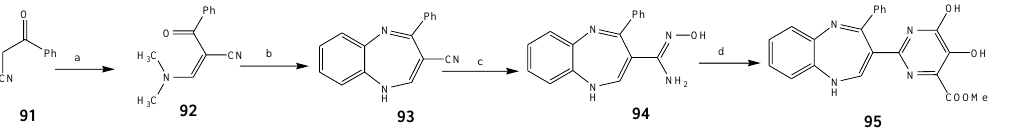
Scheme 8. Synthesis of pyrimidine derivatives of 1,5-benzodiazepine from benzoylacetonitrile. A r O a = HC(OEt) 3 /Ac 2 O/Reflux, b = MeOH/R-NH 2 . 96 :Ar = 3-NO 2 Ph; 97 :Ar = 4-OHPh; 98 :Ar = 4- ClPh; 99 :Ar = 2-ClPh; 100 :Ar = 3-NO 2 Ph,R = Me; 101 :Ar = 4-OHPh, R = Me; 102 :4-ClPh,R = Me; 103 :Ar = 3-NO 2 Ph,R = Benzyl; 104 :Ar = 3-NO 2 Ph,R = Ph, 105 :Ar = 4-OHPh,R = Ph, 106 :Ar = 2-Cl-C 6 H 4 ,R = Ph. Scheme 9. Synthesis of new benzo[5,6]chromeno[2,3- d ]pyrimidines ( 100 – 106 ).